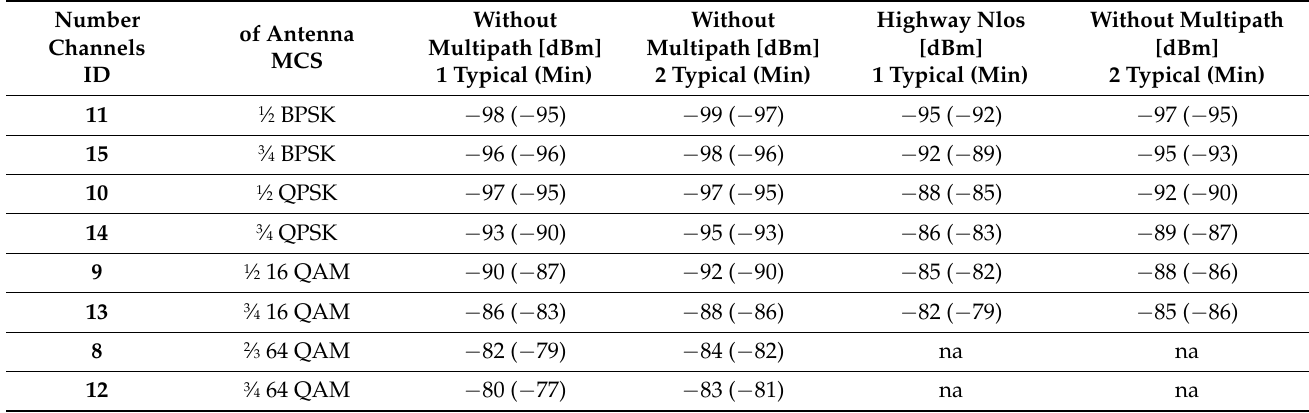
Table 2. Sensitivity felt by an MK5 module.